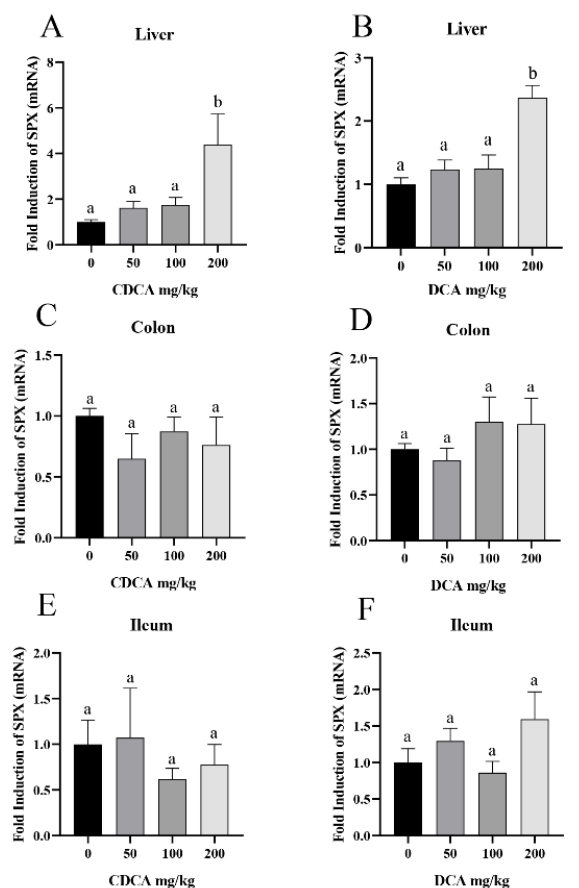
Figure 2. Bile acid promoted the expression of SPX in mouse liver. ( A ) Effect of CDCA on the expression of SPX mRNA in mouse liver. ( B ) Effect of DCA on the expression of SPX mRNA in mouse liver. ( C ) Effect of CDCA on the expression of SPX mRNA in mouse colon. ( D ) Effect of DCA on the expression of SPX mRNA in mouse colon. ( E ) Effect of CDCA on the expression of SPX mRNA in mouse ileum. ( F ) Effect of DCA on the expression of SPX mRNA in mouse ileum. After continuous gavage of bile acid for 7 days, the tissues of mice were collected to measure the expression of SPX mRNA by qPCR. Data were calculated by 2 − ∆∆ CT method, and 0 group was set as unit 1. The groups denoted by different letters represent a significant difference at p < 0.05.